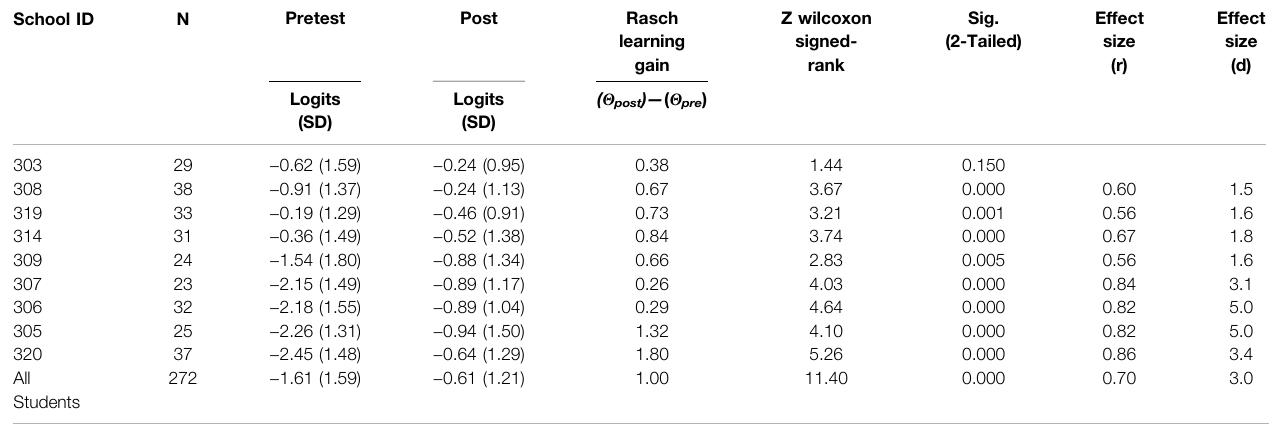
TABLE 2 | Students ’ mathematics achievement scores analysis for the pre- and post-test.